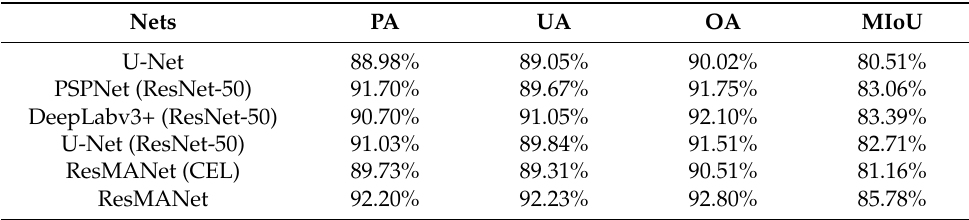
Table 3. Accuracy assessment of Hainan dataset A.